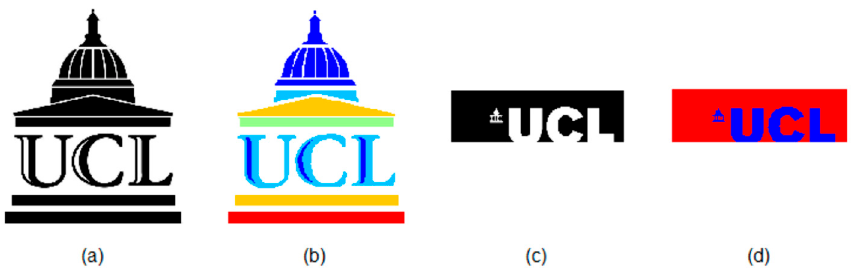
Figure 9. (Color online) Two UCL logos with different degrees of beauty or life. Note: The old logo (the left, panel a and b) is more beautiful or more living than the new one (the right, panel c and d). This is because the old one has at least 19 centers with a scaling hierarchy of 5 by the five colors, whereas the new one has a maximum of six centers with a scaling hierarchy of only 2 by blue and red. Beauty or life is determined (1) by the number of centers—the more centers, the more beautiful—and (2) by the scaling hierarchy—the more levels of scale, the more beautiful structurally.